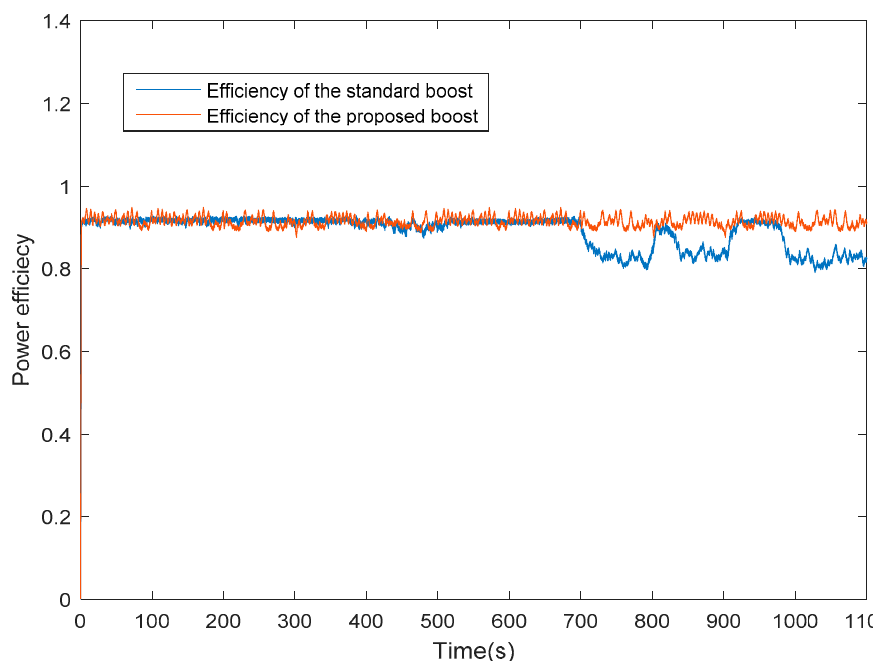
Figure 21. Measured power efficiency for the conventional and proposed converter.